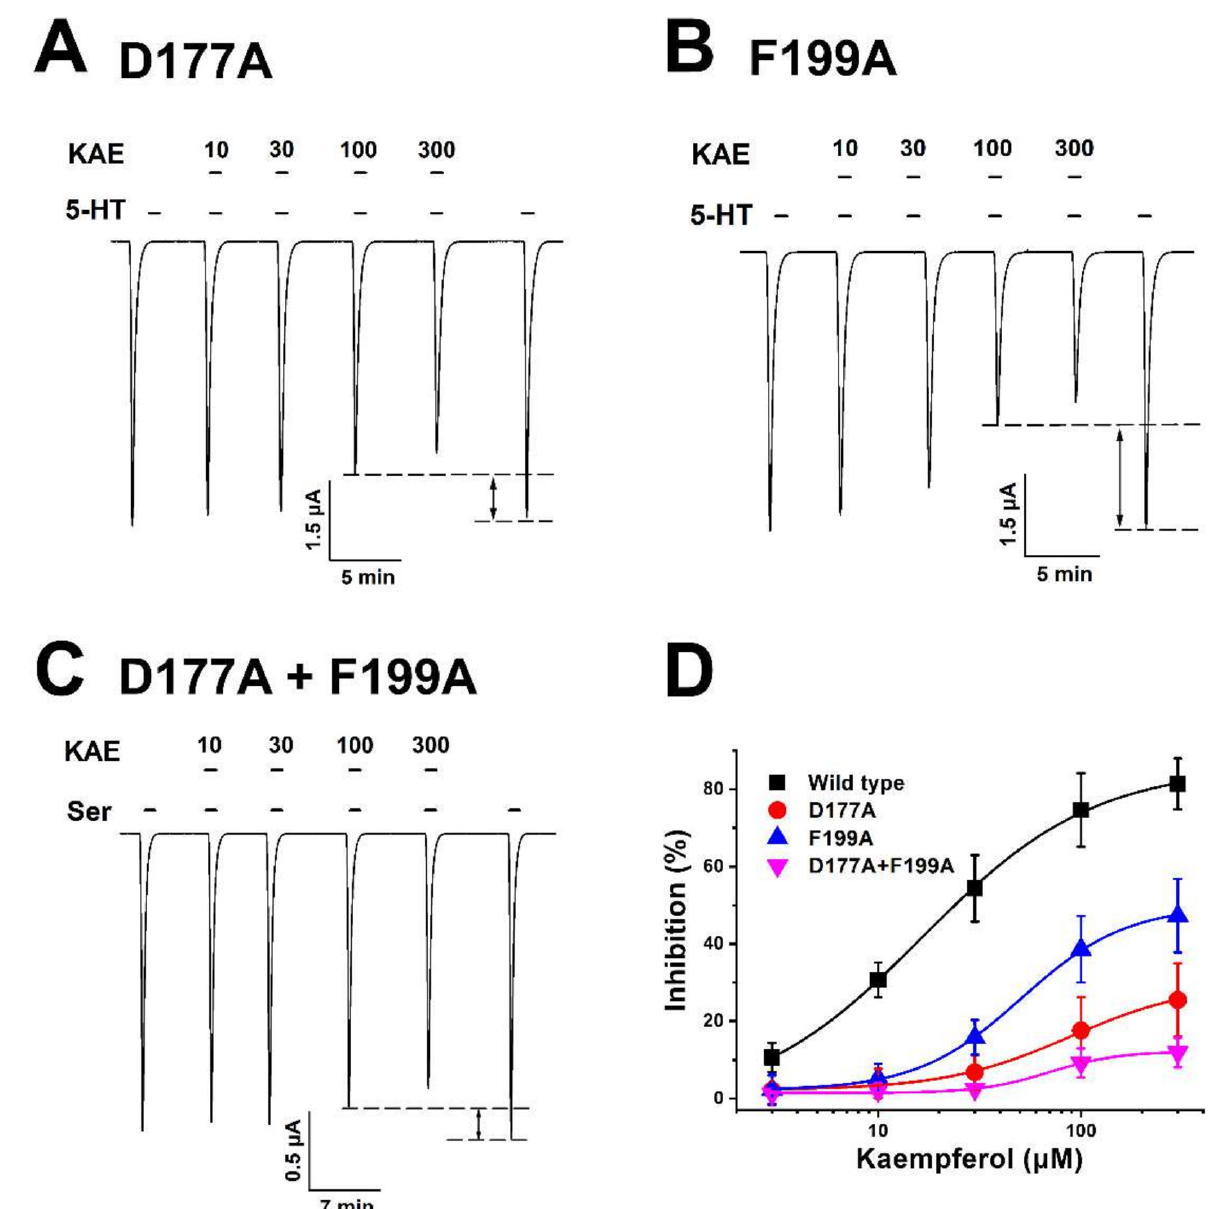
Figure 5. Inhibition of KAE according to mutant-type of 5-HT 3A receptor. ( A – C ) Inward current when KAE was applied to 5-HT 3A single-mutant types (D177 or F199 residue substitution) and double- mutant type (both D177 and F199 residue substitutions). The applied concentration of serotonin was fixed at 100 µ M, while the concentration of KAE was 10 µ M, 30 µ M, 100 µ M, or 300 µ M. Black bar indicates the applied serotonin and KAE. The black dot line indicated in the figure represents the inward current changed when KAE was applied with the control ligand (5-HT, 100 µ M) ( n = 6–8 oocytes from four different frogs). ( D ) Inhibition percentage of wild-type and single or double-mutant type of 5-HT 3A receptor by KAE. Each point represents the inhibition percentage and error value for each concentration of KAE. Data are presented as mean ± SEM ( n = 9–11 oocytes from four different frogs) according to statistical